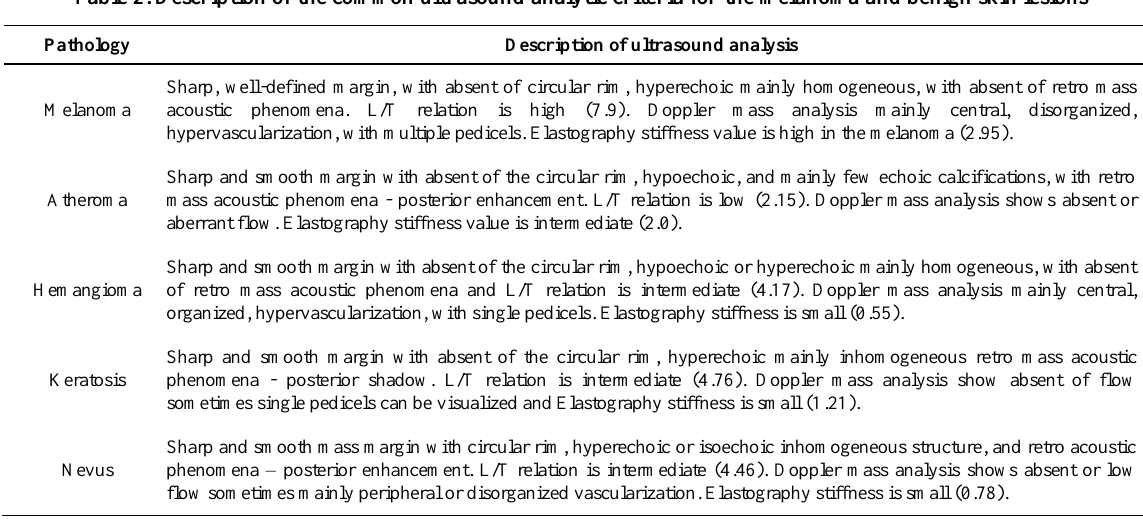
Table 2. Description of the common ultrasound analytic criteria for the melanoma and benign skin lesions